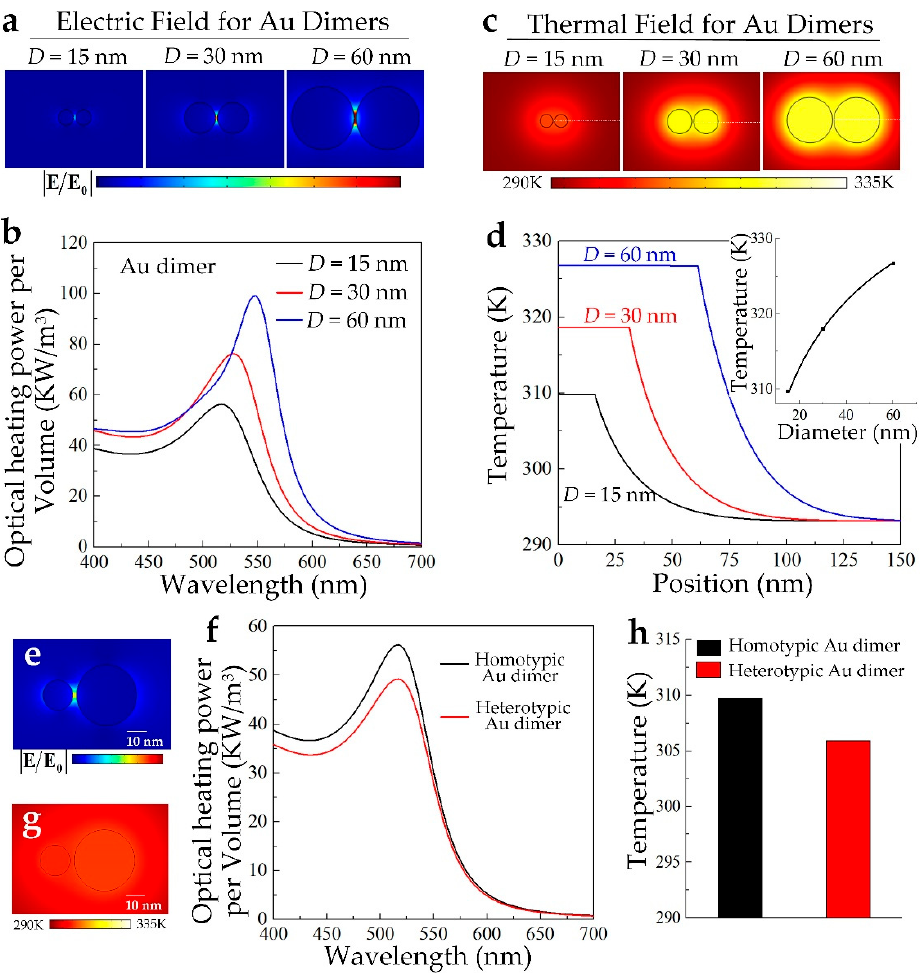
Figure 5. ( a ) LSPR-induced electric field enhancement for gold nanodimer with di ff erent particle sizes; D is the diameter of the plasmonic individuals; ( b ) Per-sphere-weighted optical heating power with a di ff erent particle size; the gap distance is 2 nm; ( c ) Corresponding quantitative temperature fields for the gold nanodimer with di ff erent particle size at t = 5 ns; the laser irradiance is 0.15 mW / µ m 2 ; ( d ) Temperature distribution along the dotted lines in (c). The inset indicates the nonlinear temperature dependence on the size of the individuals; ( e ) LSPR-induced electric field enhancement for heterotypic gold nanodimer; ( f ) The per-sphere-weighted optical heating power for heterotypic gold nano-dimer; ( g ) Corresponding quantitative temperature fields for the heterotypic gold nanodimer; the laser irradiance is 0.15 mW / µ m 2 ; ( h ) The quantitative temperature increment for homotypic and heterotypic gold nano-dimers.